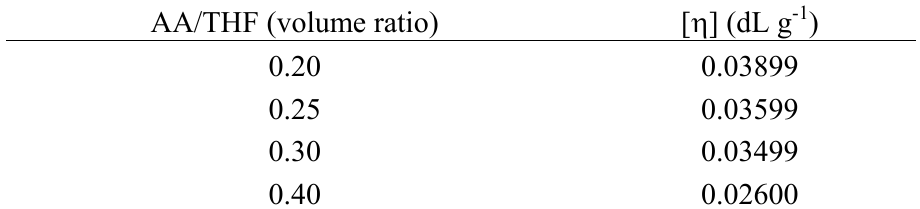
Table 2. Influence of the AA proportion on the intrinsic viscosity of poly(THF) catalyzed